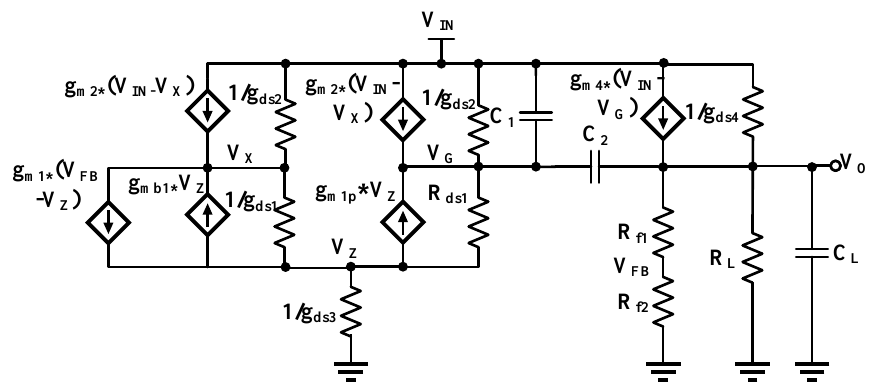
Figure 9. Small-signal macromodel of the LDO for the calculation of the power supply rejection (PSR).